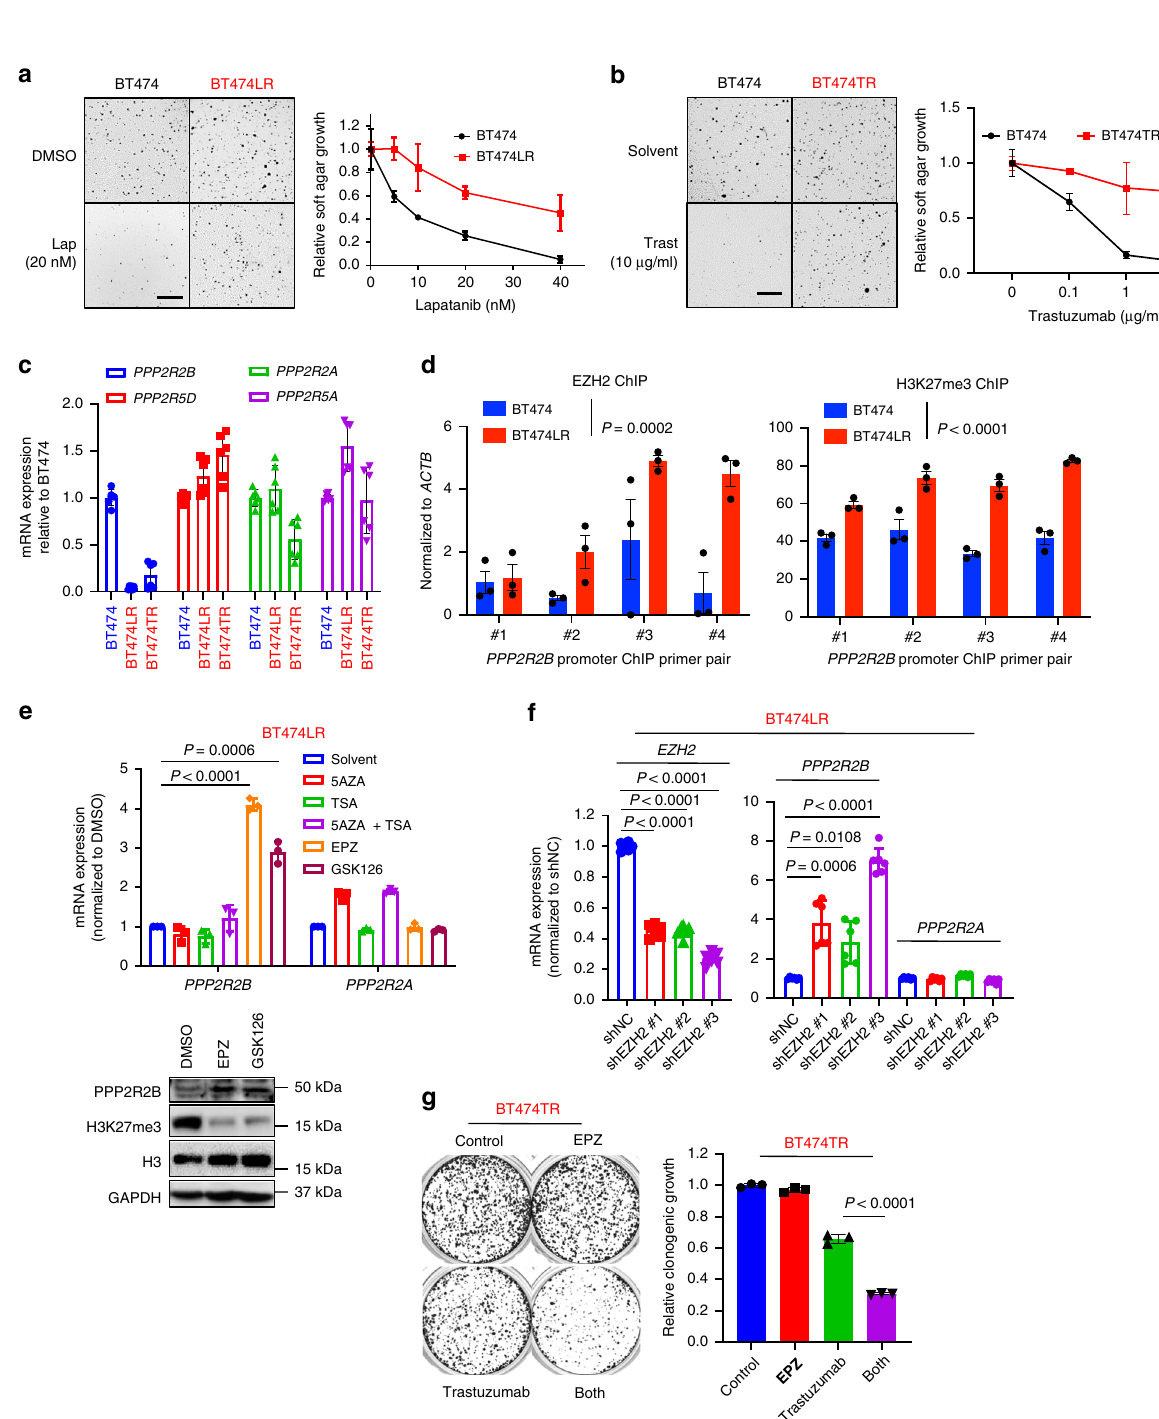
Fig. 6 Combinational effect of trastuzumab and EPZ in vivo. a Tumor volume along treatment (left) or change (%; right) of tumor volume from baseline tumors in NCR nude mice bearing UACC812 xenografts were treated with vehicle ( n = 7), EPZ ( n = 8), trastuzumab (trast; n = 8), or in combination (EPZ + Trast; n = 7). EPZ was administered once per day via oral gavage at 250 mg/kg, while trastuzumab was administered once per week via intraperitoneal injection at a loading dose of 30mg/kg and subsequently 15mg/kg. Tumor volumes were measured twice a week. b Tumor volume along treatment (left) or change (%; right) of tumor volume from baseline tumors in NCR nude mice bearing MB361 xenografts were treated with vehicle ( n = 7), EPZ ( n = 6), trastuzumab (trast; n = 6), or in combination (EPZ + Trast; n = 6). EPZ was administered once per day via oral gavage at 250 mg/kg, while trastuzumab was administered once every six days via intraperitoneal injection at a loading dose of 30mg/kg and subsequently 15mg/kg. P values in a and b were determined by two-way ANOVA and adjusted with Bonferroni correction. c Representative images (left) and quanti fi cation (right) of IHC with tumors from a . Data were acquired with tumors from seven mice ( n = 7) from each group. Scale bar: 150 µ m. P values were determined with two-tailed Student ’ s t